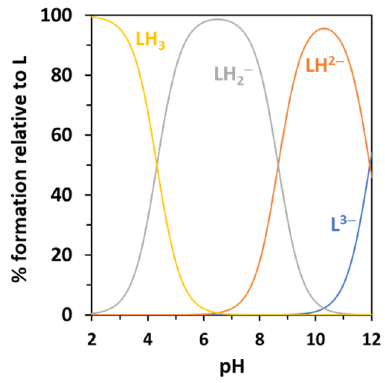
Figure 3. Distribution diagram of caffeinate species as a function of pH in KCl (aq) at I = 0.2 mol · dm − 3 and T = 298.15 K. c L =1 mmol · dm − 3 .